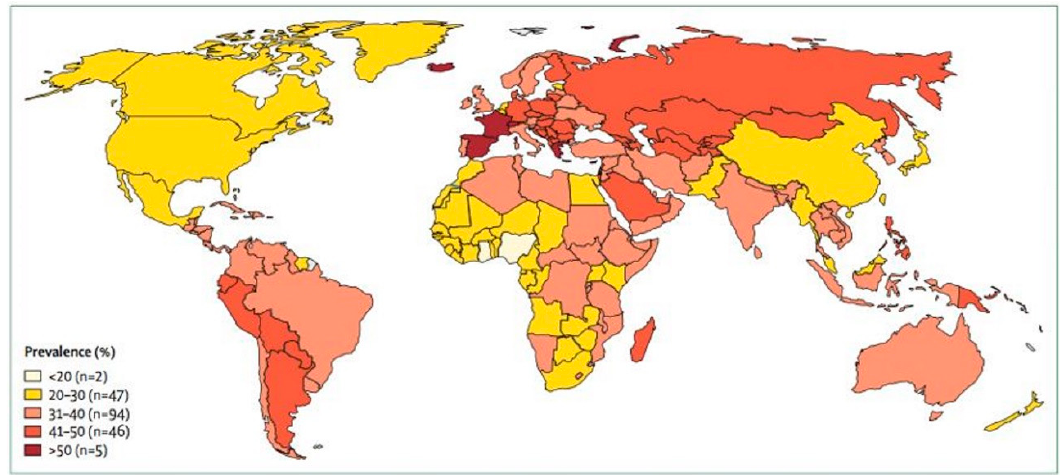
Figure 1. World prevalence estimate of untreated caries in permanent dentition in 2017, from the Institute of Health Metrics and Evaluation.